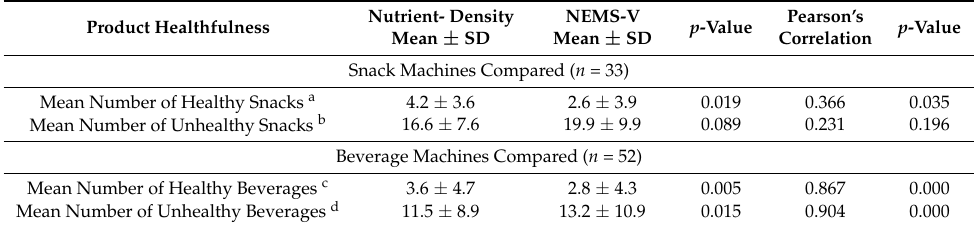
Table 7. VENDing nutrient-density score and NEMS-V comparison of product healthfulness.